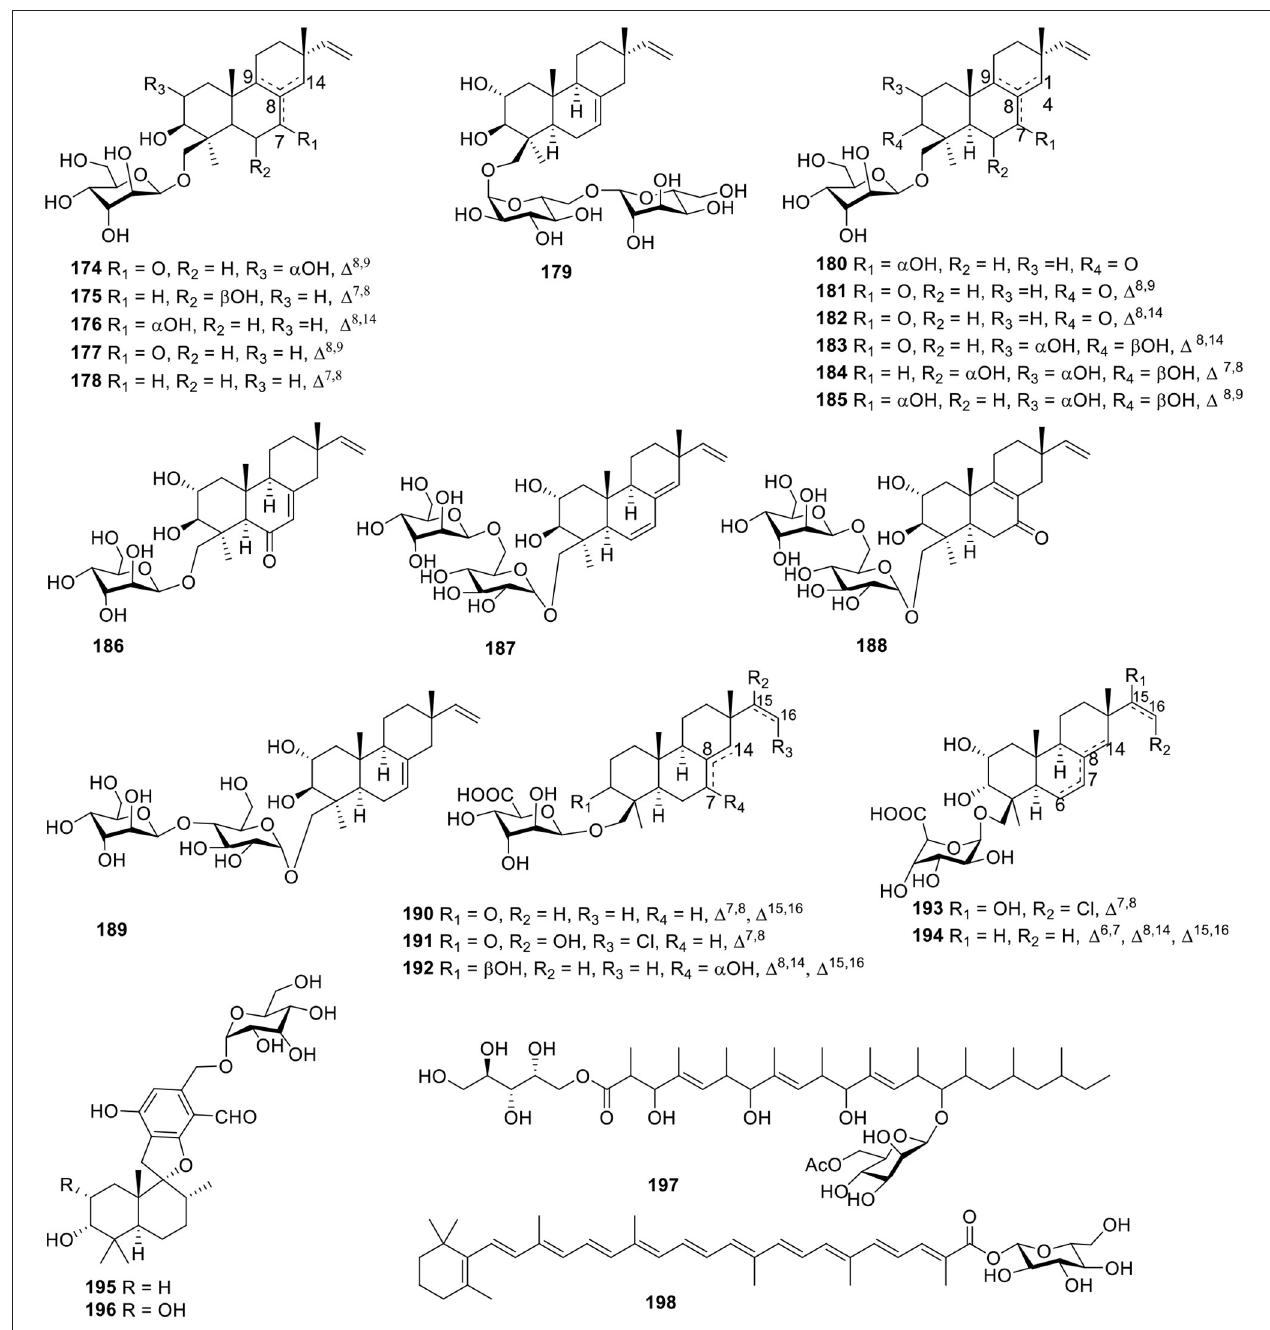
FIGURE 13 | Chemical structures of compounds 174–198 derived from marine-sourced fungi.